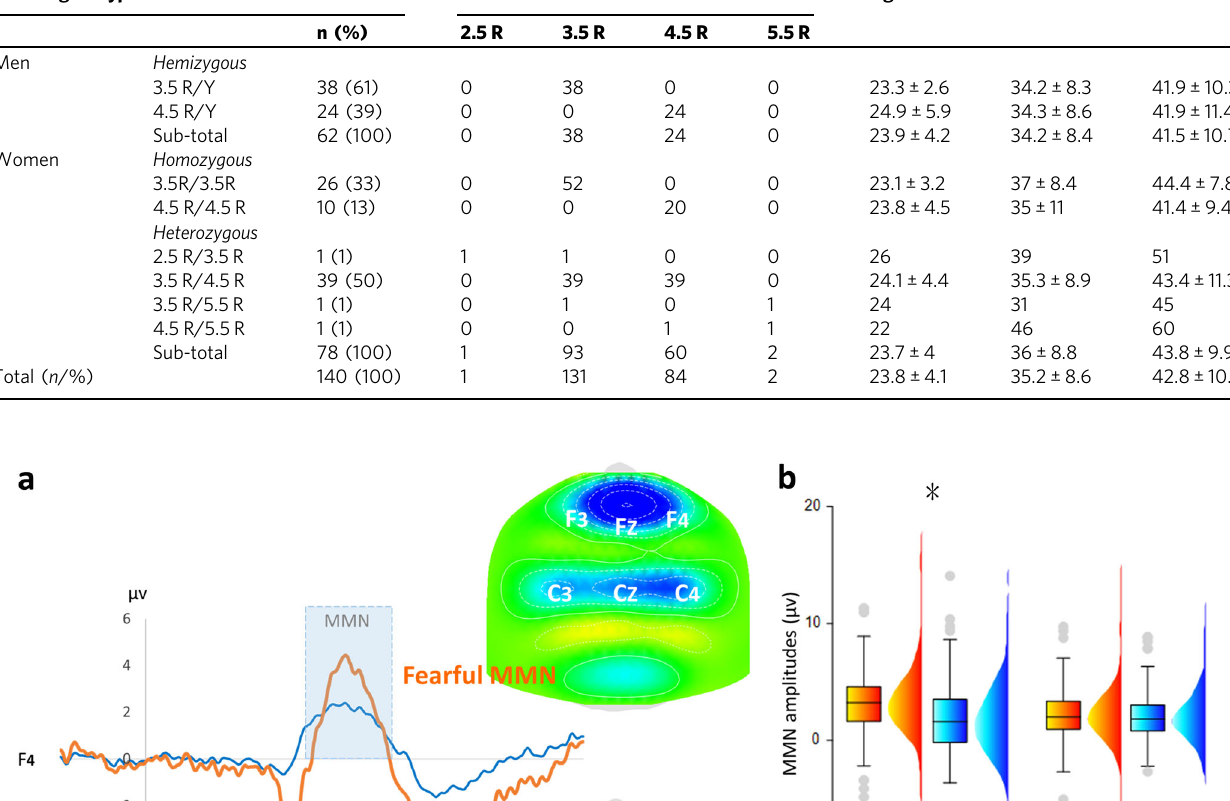
Table 2 Demographic and descriptive statistics of MAOA-uVNTR genotypes in the Taiwanese population (mean ± SD). MOAO genotypes Alleles